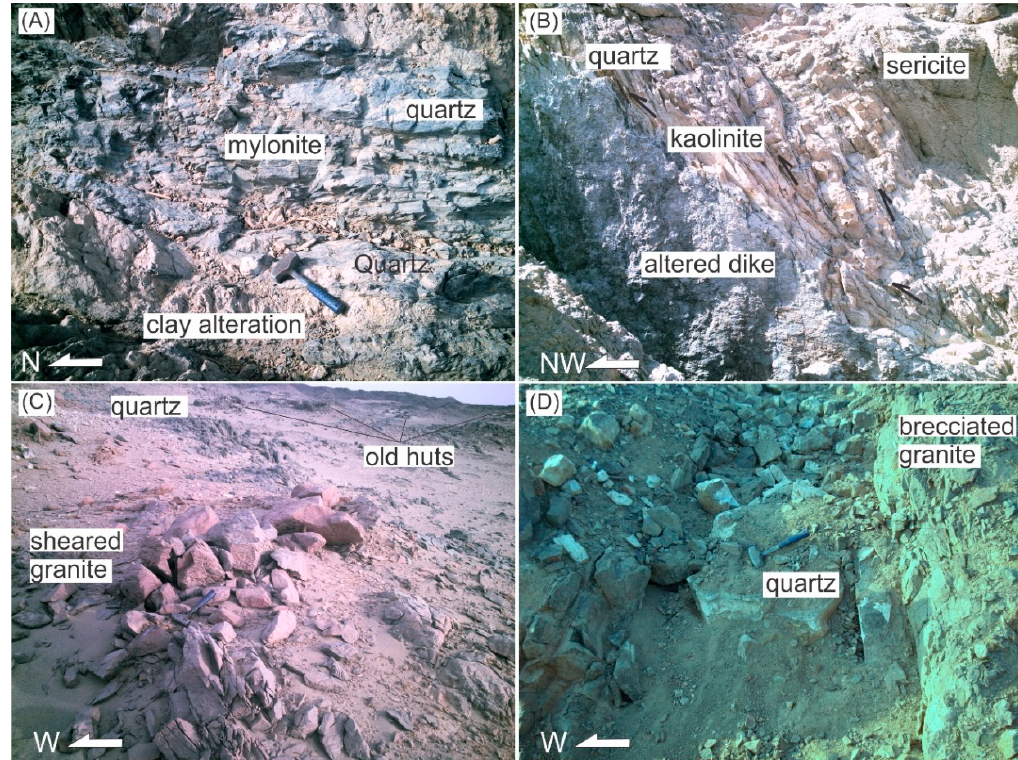
Figure 15. Field relationships of the mineralized quartz veins in the Bokari mine area: ( A ) Mylonite zone and associated quartz vein on one side and clay mineral alteration on the other side, ( B ) Kaolinite and quartz veins bordered by sericitized granodiorite and altered basic dike at the Bokari mine, ( C ) Scattered quartz vein segments and pockets in brecciated granodiorite near old miner huts at the Bokari mine area, ( D ) Thick (~1 m-thick) quartz vein trending ~N–S and is mined out selectively in areas where hydrothermal alteration selvages are abundant, whereas zones lacking the altered wallrock are not mined (barren?).